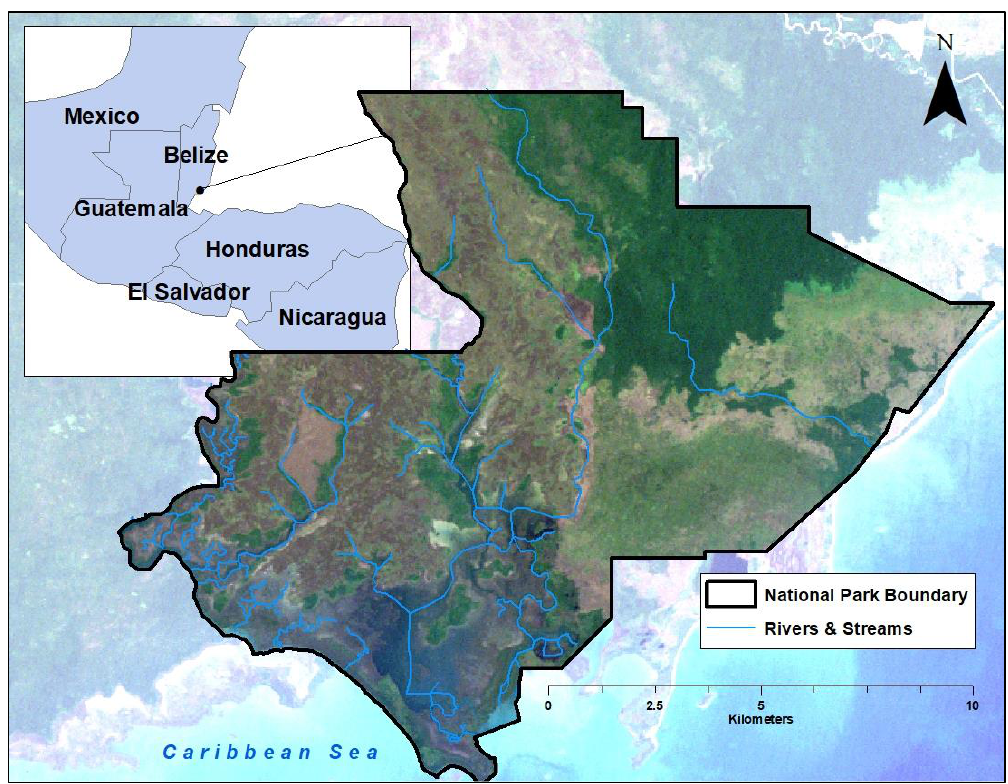
Figure 1. Map of Payne’s Creek National Park (PCNP), showing nearby countries in Central America. Image of PCNP is a true color composite from Landsat 5 TM taken in March 2011. Shapefile of Central America from Natural Earth. Shapefile of Belize and its rivers from Biodiversity and Environmental Resource Data System of Belize. Shapefile of Payne’s Creek National Park from Protected Planet.